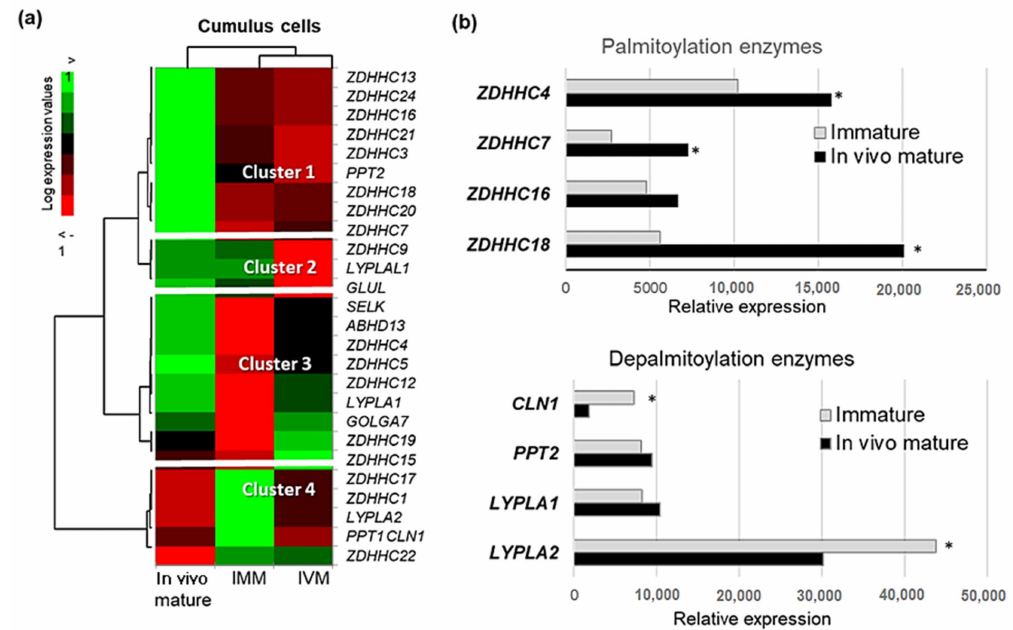
Figure 8. Gene expression protein palmitoylation related enzymes in bovine cumulus cells (CC) before and after oocyte maturation. ( a ) Heat map representation of gene expression in CC surrounded either immature oocytes (IMM), or in vitro mature oocytes (IVM), or in vivo mature oocytes. ( b ) Expression of the most abundant parmitoyl-transferases and acyl- thioesterases in bovine CC before and after 24 h in vitro maturation (IVM). Significant difference at p < 0.05 is marked by asterisks (*).